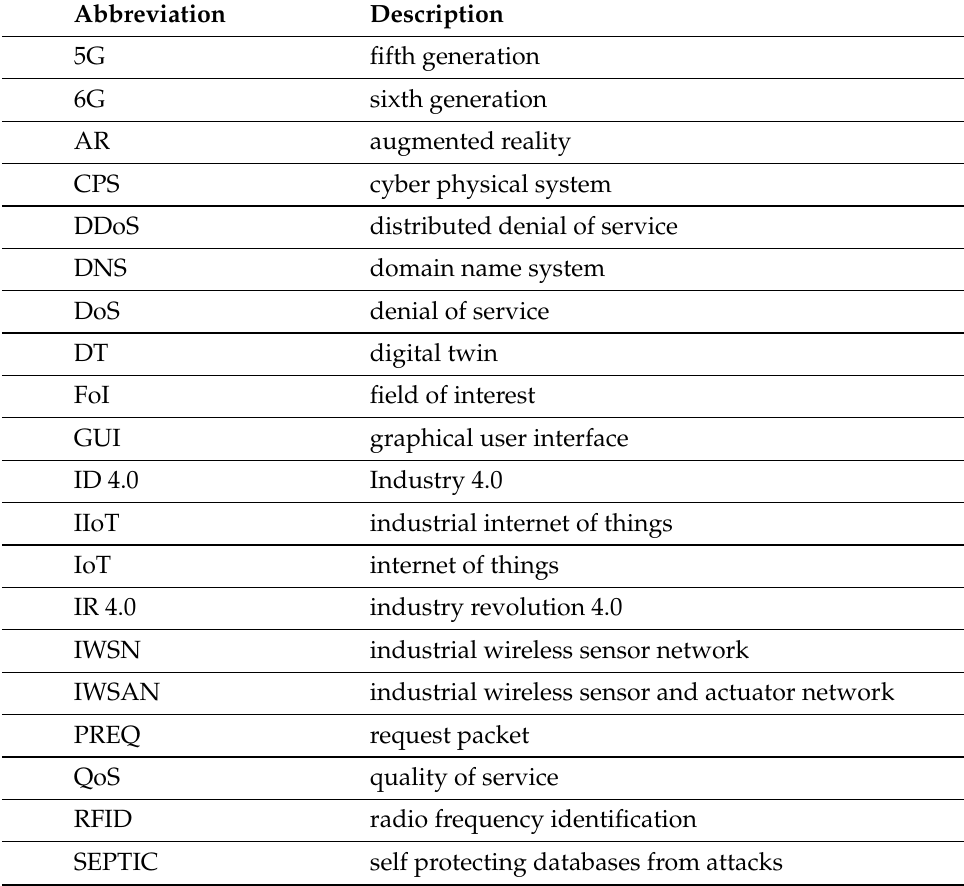
Table 1. List of